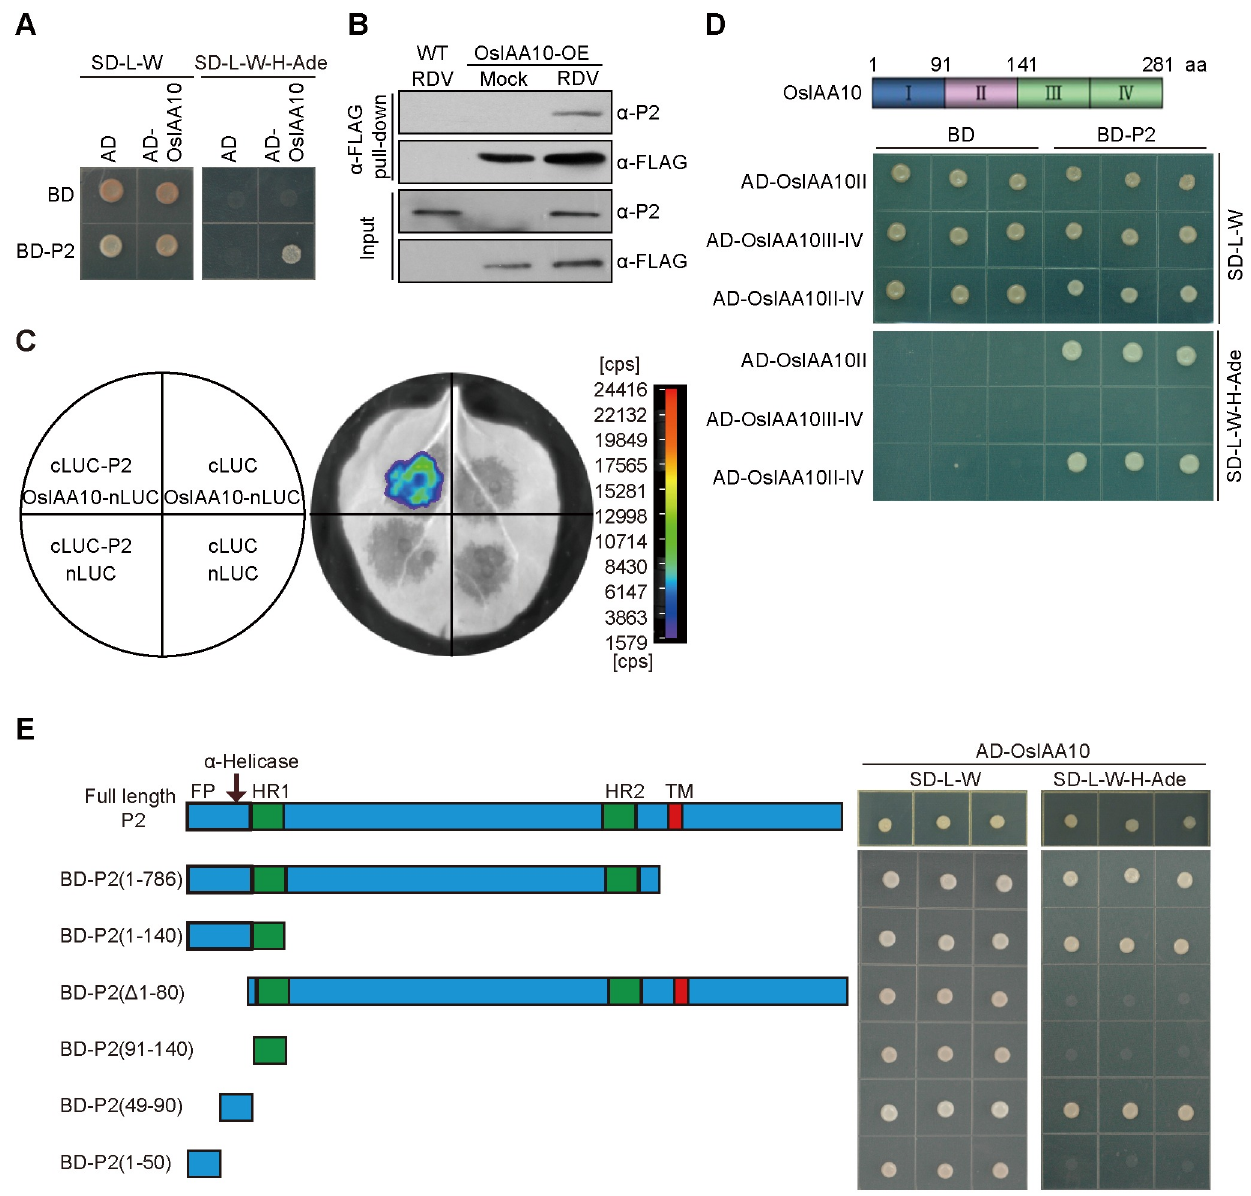
Fig 2. The RDV P2 protein interacts with OsIAA10. (A) RDV P2 interacts with OsIAA10 in yeast. Yeast transformants were spotted on the control medium (SD-Leu/-Trp (SD-L-W)) and selection medium (SD-Leu/-Trp/-His/-Ade (SD-L-W-H-Ade)). AD, activating domain; BD, binding domain; SD, synthetic dropout. (B) Co-immunoprecipitation confirms the interaction between P2 and OsIAA10 in RDV-infected FLAG-OsIAA10 overexpressing (OsIAA10-OE) rice. WT, wild type rice; Mock, mock-inoculated rice; RDV, RDV-infected rice. (C) LCI assay shows interaction between P2 and OsIAA10 in vivo . The left diagram indicates the leaf panels that were infiltrated with A . tumefaciens containing the different combinations of indicated constructs. Cps indicates signal counts per second. (D) P2 interacts with domain II of OsIAA10. (E) Determination of the functional domains of P2 that interact with OsIAA10. The prey protein AD-OsIAA10 was expressed with the indicated bait proteins in yeast AH109 cells. Interaction was indicated by the ability of cells to grow on medium SD-L-W-H-Ade. degraded through the ubiquitin-26S proteasome degradation pathway (S2B Fig) [19]. We also demonstrated the auxin-dependent interaction of OsIAA10 with the auxin receptor OsTIR1 (S2C Fig) through its domain II (S2D Fig). Finally, we mapped the P2-interacting of OsIAA10 to domain II (Fig 2D and S2D Fig).